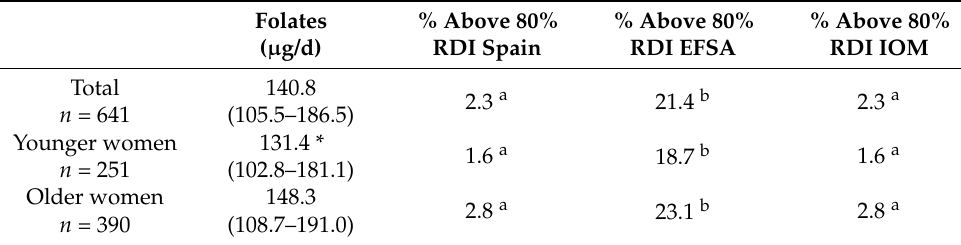
Table 6. Folates intake and prevalence of adequacy (percentage of population above 80% RDI) in women of childbearing age from the ANIBES